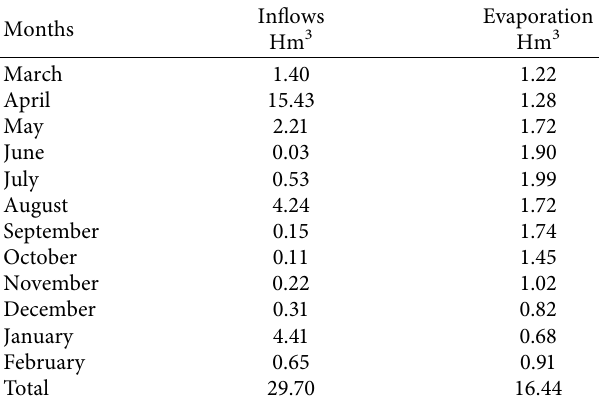
Table 3: Average monthly water infows and evaporation (Hm 3